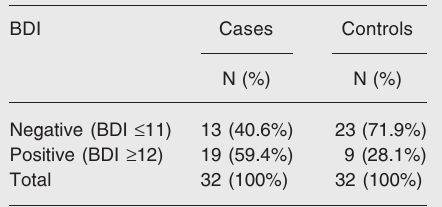
Table 2. Beck Depression Inventory (BDI) scores for patients with lithiasis (N = 32) compared to control subjects (N =